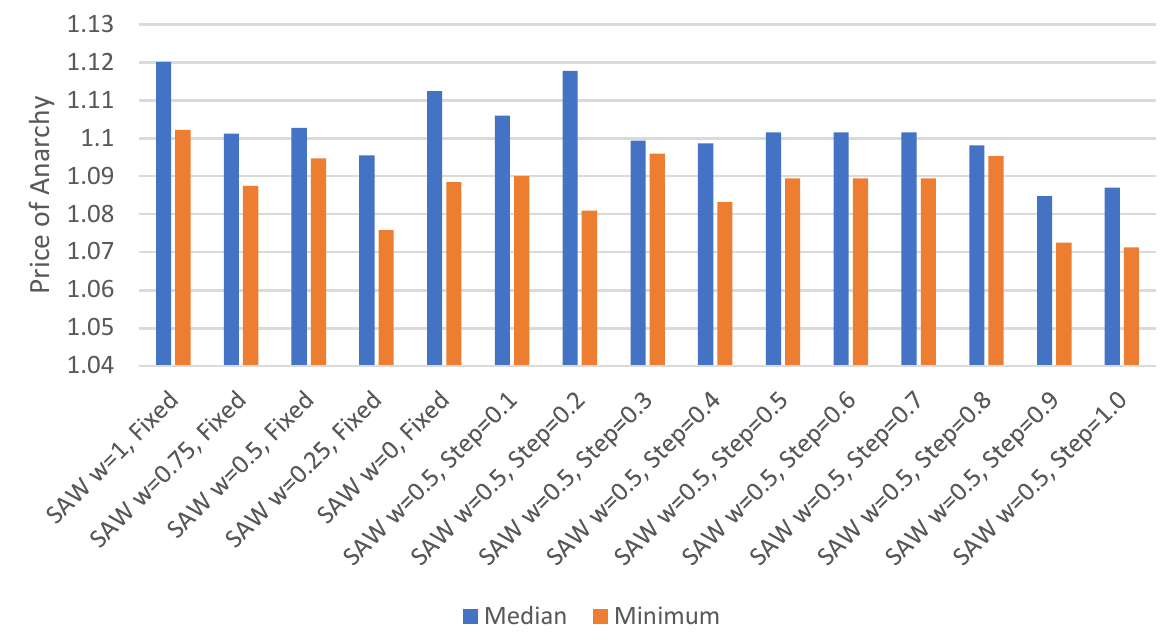
Figure 10. Minimum/median price of anarchy with TIS and direct experience. User Equilibrium Points. Figure 11 presents the number of occurrences of user for each set of parameters. Equilibrium occurred with all sets of parameters but was highest where the SAW weight was fixed, and weight was not equal to 0. This method was the only one found to have reached equilibrium regardless of the parameters used.